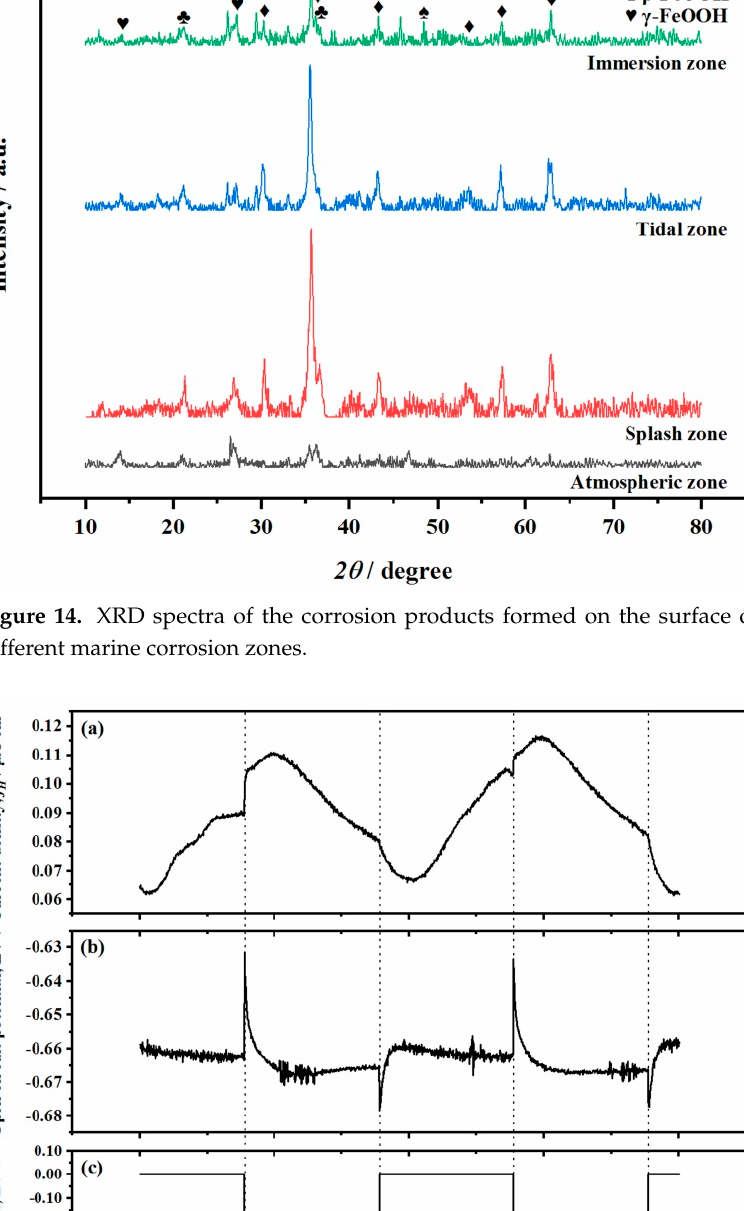
14 of 20 Figure 13. Relationship between the time-averaged hydrogen permeation current density ( j aH ) and the time-averaged corrosion thickness loss rate ( r ) of the hydrogen permeation sensors in the entire duration of the outdoor hydrogen permeation test. 3.1.3. Corrosion Products Analysis and Its Effect on Hydrogen Permeation Different corrosive environments between marine corrosion zones may not only lead to differences in the corrosion rates of steel, but also differences in the composition of corrosion products. Figure 14 shows the XRD spectra of the corrosion products formed on the surface of sensors exposed to different marine corrosion zones. It can be seen that the corrosion products were mainly iron oxides, consisting of goethite ( α -FeOOH), lepidocrocite ( γ -FeOOH), akaganeite ( β -FeOOH) and magnetite (Fe 3 O 4 ). No sign of FeS was found in the XRD pattern of the corrosion products formed in the immersion zone, owing to the overlap of some peaks and less content. The XRD pattern shows a high proportion of α -FeOOH in the corrosion products formed in the marine atmospheric zone. Previous studies have shown that a corrosion environment with a low content of chloride ions can facilitate the formation of α -FeOOH in the corrosion products, thus leading to a denser corrosion products layer. This dense corrosion products layer can largely hinder the penetration of O 2 and Cl − to steel surface, thereby suppressing elec- trochemical corrosion and decreasing hydrogen permeation ultimately (Figure 7a) [53,54]. On the contrary, an environment with a high Cl − content favors the formation of β -FeOOH [55,56] β -FeOOH can alter the structure of corrosion products layer such as facilitating the formation of cracks and pores, thereby promoting corrosion and hydrogen permeation into steel via providing extra channels for the penetration of corrosive sub-